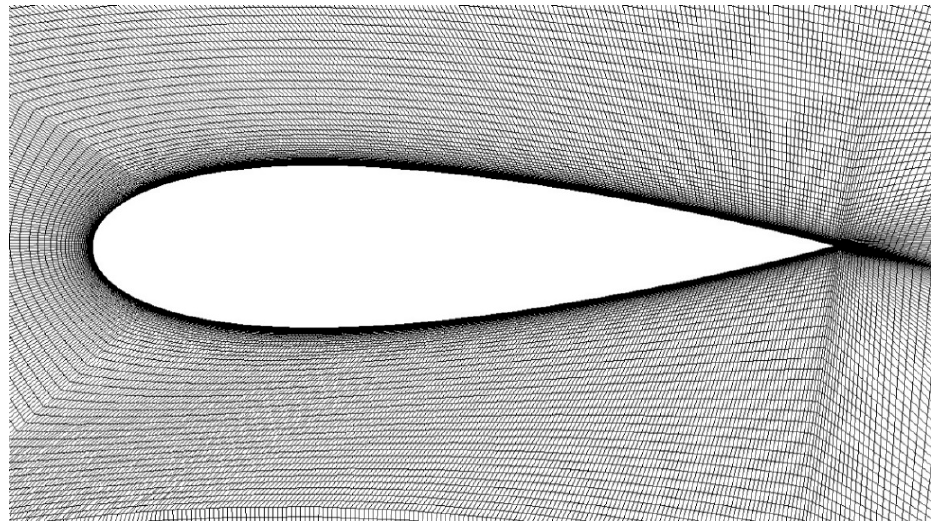
Figure 7. Mesh around the blade.